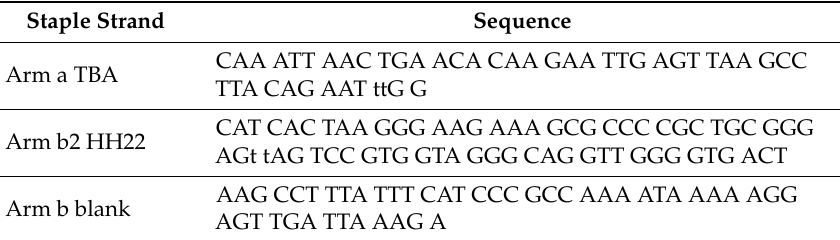
Table 1. Sequence of modified staple